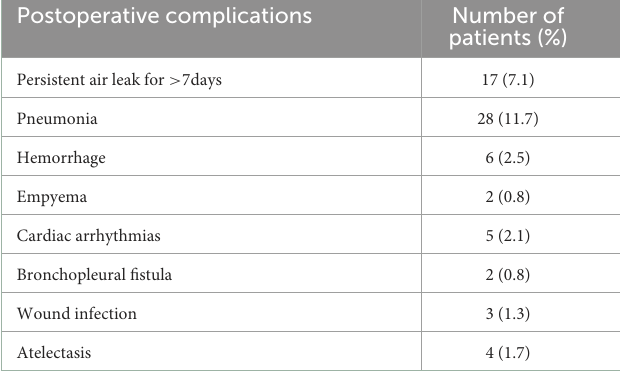
TABLE 2 Postoperative complications after surgery for 240 patients with bronchiectasis.